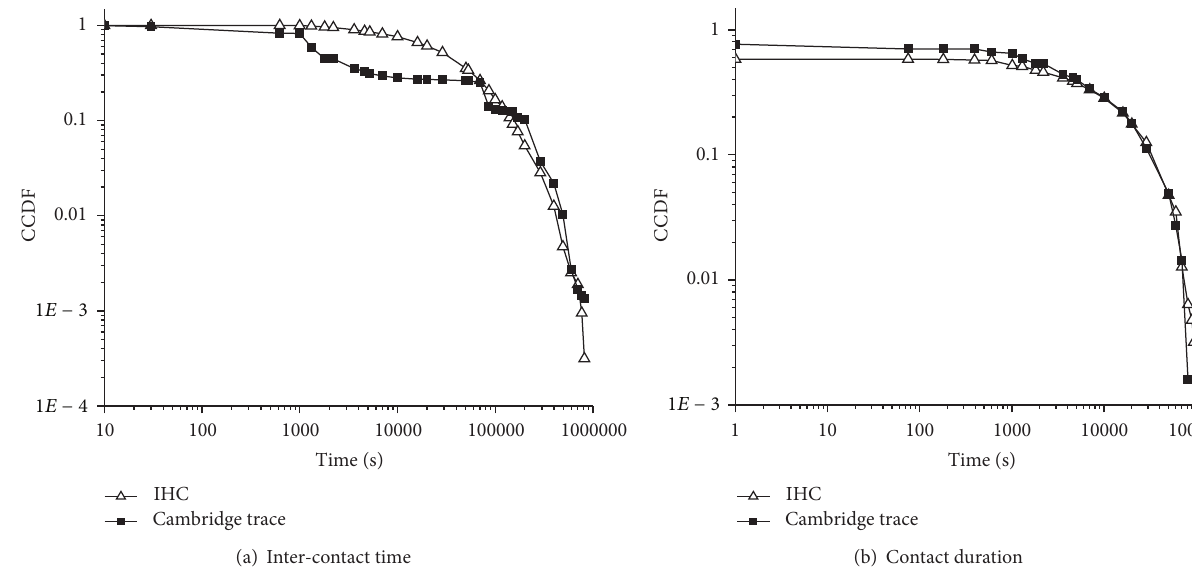
Figure 7: Reproduce Cambridge trace using